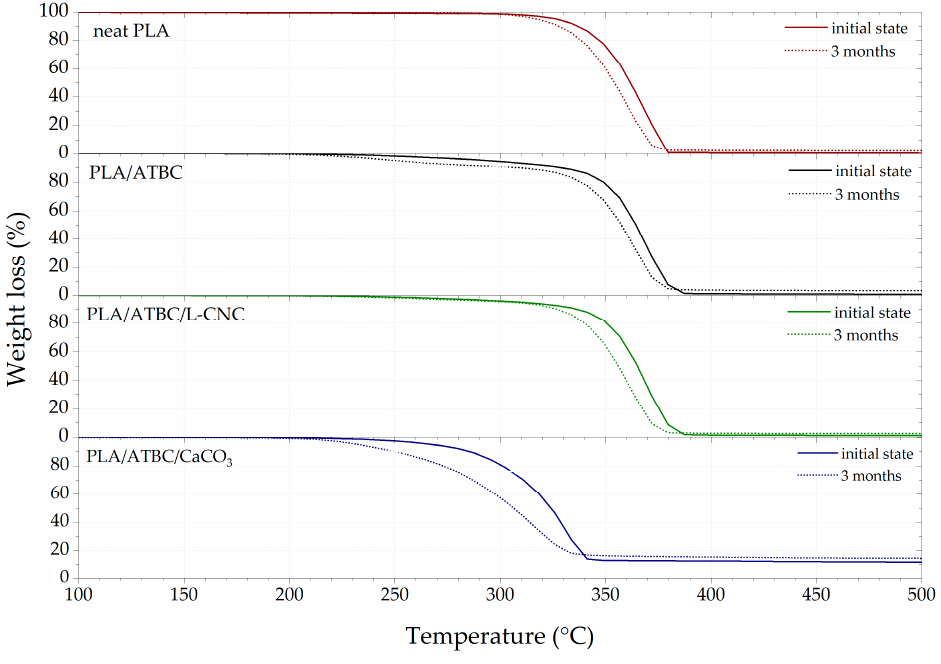
Figure 4. Thermogravimetric analysis (TGA) curves of PLA biocomposites at initial state and after 3 months of biodegradation in freshwater biotope. Table 6. Thermogravimetric analysis (TGA) data of PLA biocomposites exposed to three months of biodegradation in freshwater biotope.